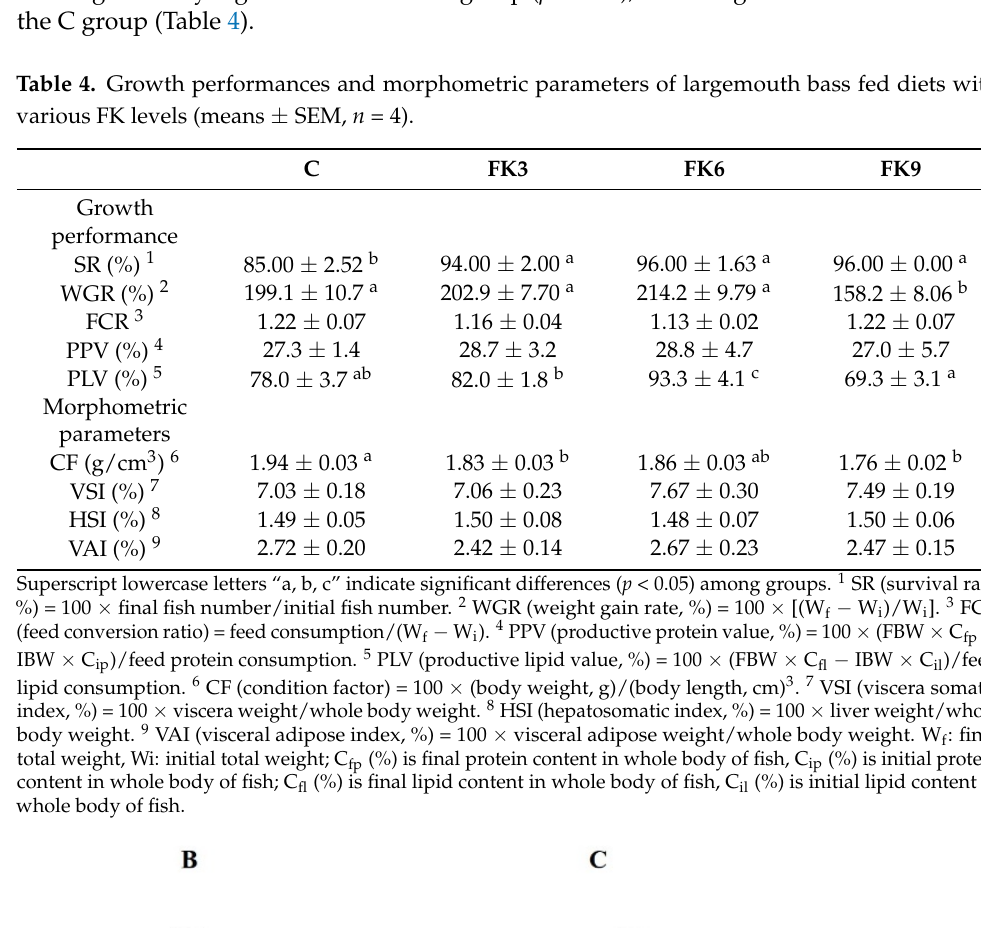
Table 5. Macro-nutrient compositions and Cu content in whole body, liver tissue and feces of large- mouth bass fed diets with various FK levels (in wet basis, means ± SEM. n = 4). C